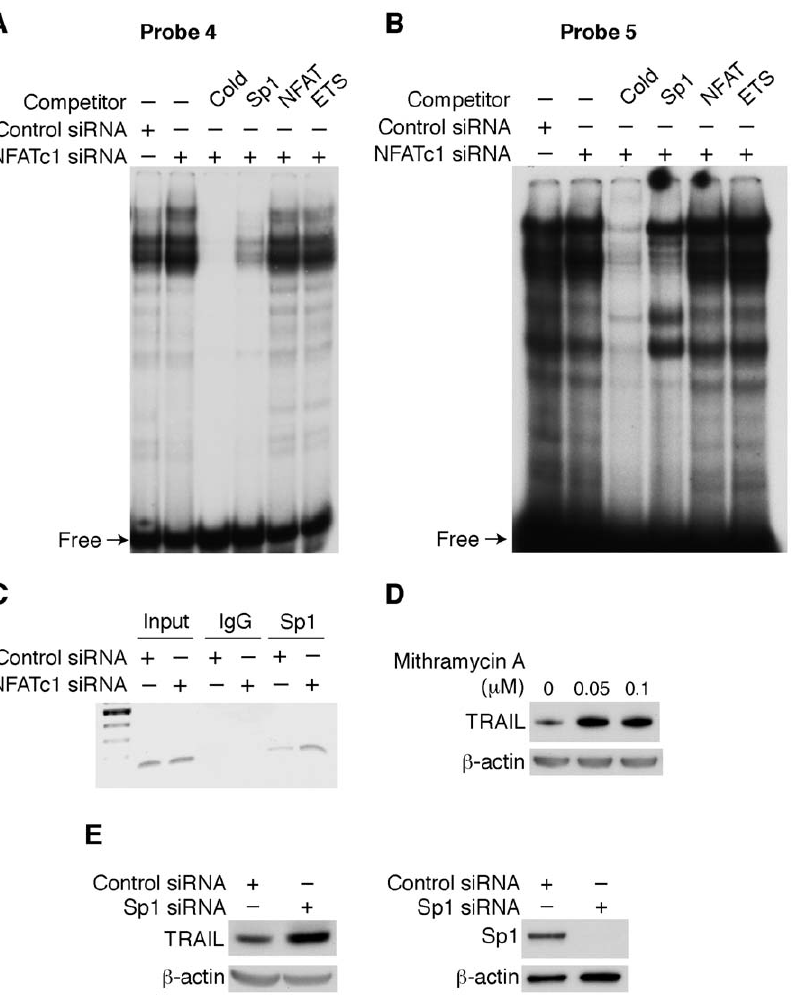
Figure 6. Sp1 mediated NFATc1 regulation of TRAIL expression. HT29 cells were transiently transfected with control siRNA or siRNA targeting NFATc1. Nuclear protein was extracted and EMSAs performed. Nuclear extracts were incubated with 32 P-labeled probe 4 ( A ) or probe 5 ( B ) alone or in the presence of unlabeled wild type ( cold ) probe 4 or probe 5, the Sp1 oligonucleotide, the NFAT oligonucleotide, or the ETS oligonucleotide, respectively. ( C ) HT29 cells were subjected to ChIP assay; soluble chromatin was prepared from HT29 cells transfected with control siRNA or siRNA targeting NFATc1 and immunoprecipitated with Sp1 antibody or IgG. Total (Input) and immunoprecipitated DNAs were then PCR- amplified using primer pairs covering the Sp1 binding sites within the human TRAIL promoter. ( D ) HT29 cells were treated with the Sp1 inhibitor mithramycin for 24 h and total protein extracted and Western blotting performed using anti-TRAIL antibody. ( E ) HT29 cells were transiently transfected with control siRNA or siRNA targeting Sp1. Forty-eight h after transfection, total protein was extracted and Western blotting performed to assess TRAIL expression (left panel) or to confirm knockdown of Sp1 (right panel). Membranes were stripped and re-probed with anti- b -actin antibody to confirm equal